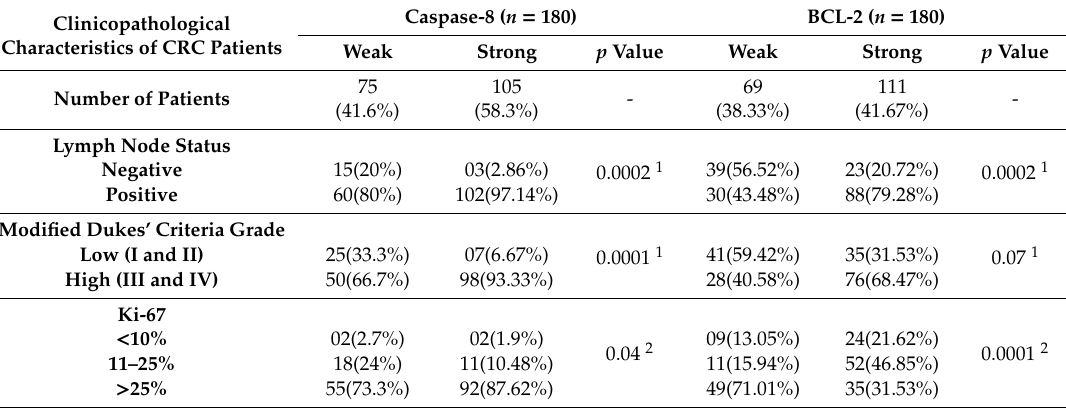
Figure 8. Expression of BCL-2 and caspase-8 in primary colorectal tumors. ( A ) Kaplan–Meier survival curve estimated by BCL-2 staining in colorectal cancer (CRC) tumors (log-rank × 2 = 30.75, p < 0.0001), ( B ) Kaplan–Meier survival estimated by caspase-8 staining in CRC tumors (log-rank × 2 = 2.61, p = 0.10). Immunohistochemical staining for BCL-2 and caspase-8 in colorectal carcinoma. Colorectal adenocarcinoma with a high modified Dukes’ classification (“3” and “4”) showing: ( C ) Strong cytoplasmic staining of BCL-2, and ( E ) weak BCL-2 cytoplasmic staining. Strong cytoplasmic staining of caspase-8 ( D ), and ( F ) weak caspase-8. Magnification: 40×. Table 3. Clinicopathological characteristics of CRC patients in relation to caspase-8 and BCL-2 expression. Distributions of tumor caspase-8 and BCL-2 expression categorizations according to clinical-pathological and Ki-67 expression (percentages in parenthesis). High expression of caspase-8 was associated with higher tumor grade, lymph node metastasis, and proliferation (Ki-67), while high expression of BCL-2 was associated with higher tumor grade and lymph node metastasis. Fisher’s exact = 1, chi-square =